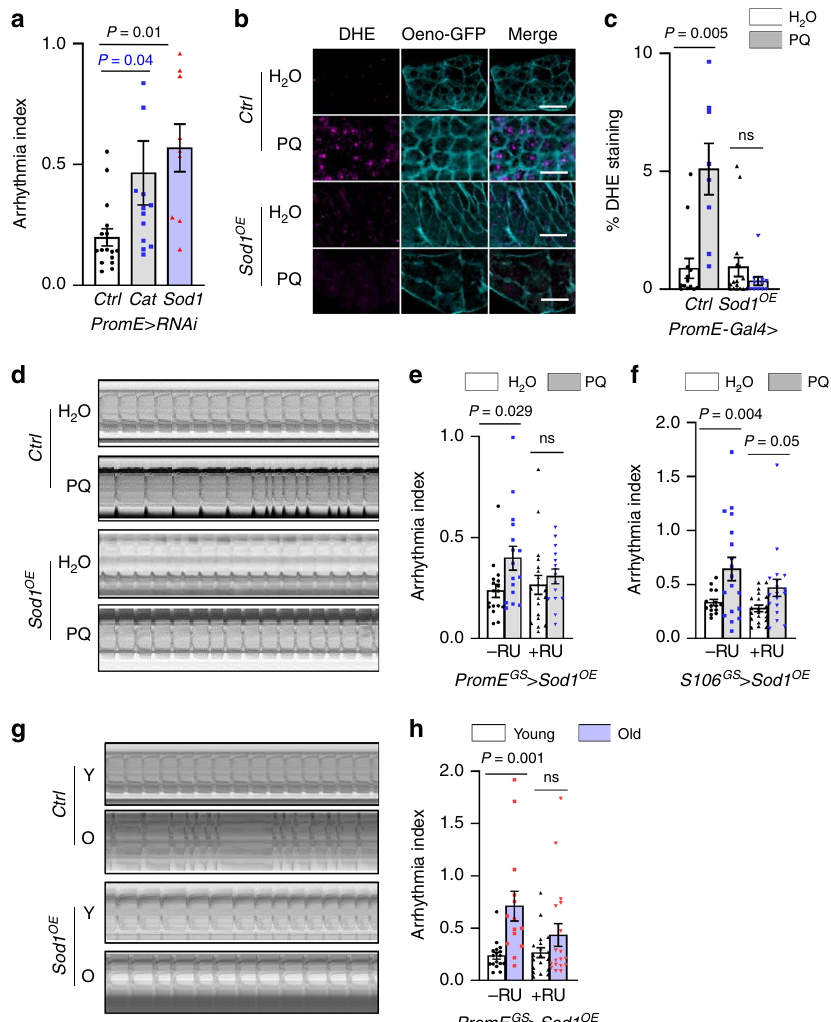
Fig. 1 Oenocyte ROS homeostasis non-autonomously modulates cardiac function. a Arrhythmia index of oenocyte-speci fi c Cat (n = 9) and Sod1 (n = 13) knockdown fl ies (1-week-old). Ctrl genotype is PromE > attP40 (n = 16). b Representative images of ROS levels in dissected oenocytes from fl ies fed on normal diet (white bar) or 10mM paraquat (grey bar). All fl ies express mCD8::GFP under PromE-Gal4 . Sod1 was speci fi cally overexpressed in the oenocytes ( Sod1 OE ). Scale bar: 20 µ m. c Quanti fi cation of the percentage of DHE-positive staining in region of interest ROIs from 5 fl ies (n left-right = 13, 8, 12, 16 ROIs). d Representative M-mode showing heart contraction in control and Sod1 overexpression fl ies fed on normal or 10mM paraquat food. Sod1 was expressed using the GeneSwitch PromE GS - Gal4 ( + RU). Ctrl genotype is PromE GS > Sod1 OE with no RU ( − RU). e Arrhythmia index of control and oenocyte-speci fi c Sod1 overexpression fl ies fed on normal or 10 mM paraquat diets (n left-right = 17, 16, 19, 15 fl ies). f Arrhythmia index of control and fat body/gut-speci fi c Sod1 ( S106-Gal4 > Sod1OE ) overexpression fl ies fed on normal or 10 mM paraquat diets. Overexpression speci fi cally in fat body and gut (n left-right = 15, 18, 21, 17 fl ies). g Representative M-mode showing heart contraction in young (2 weeks, white bar) and old (6 weeks, purple bar) fl ies with or without oenocyte- speci fi c Sod1 overexpression. Ctrl genotype is PromE GS > Sod1 OE with no RU. h Arrhythmia index of control and oenocyte-speci fi c Sod1 OE fl ies at young and old ages (n left-right = 17, 19, 14, 18 fl ies). Data are represented as mean ± SEM. P values are calculated using either two-way ANOVA ( c , e , f , h ) or